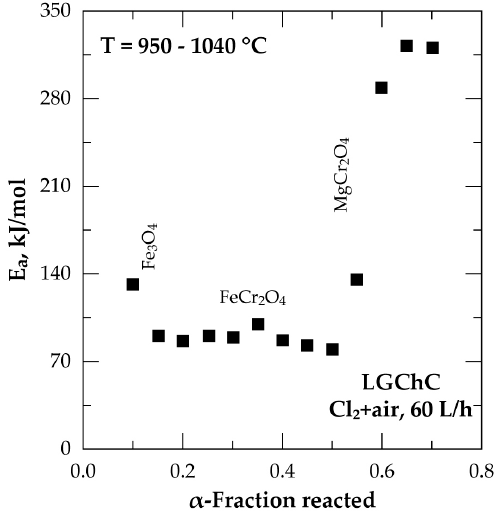
Figure 15. Plot of the apparent activation energy (E a ) versus fraction reacted for the treatment of LGChC with Cl 2 +air at 950–1040 °C.